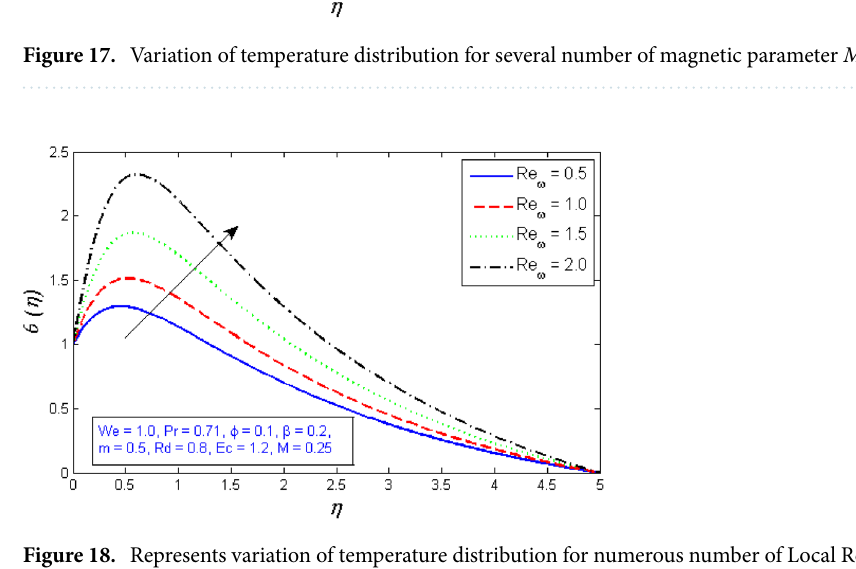
Figure 18. Represents variation of temperature distribution for numerous number of Local Reynolds number established on the disc angular velocity Re ω